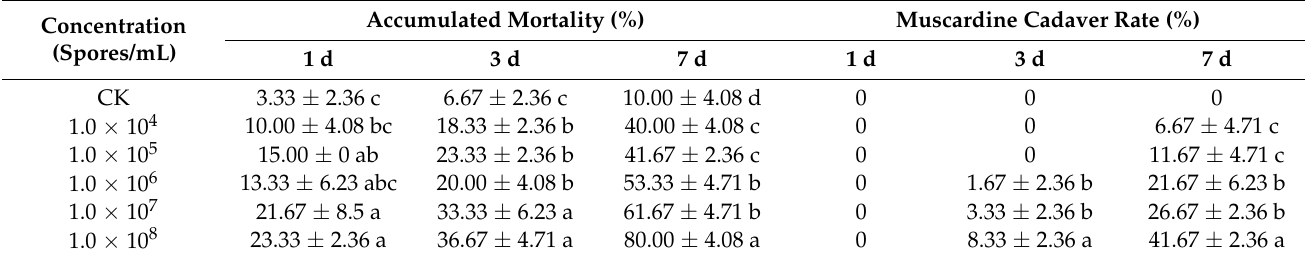
Table 5. Pathogenicity of I. javanica in different concentrations against P. striolata . Concentration